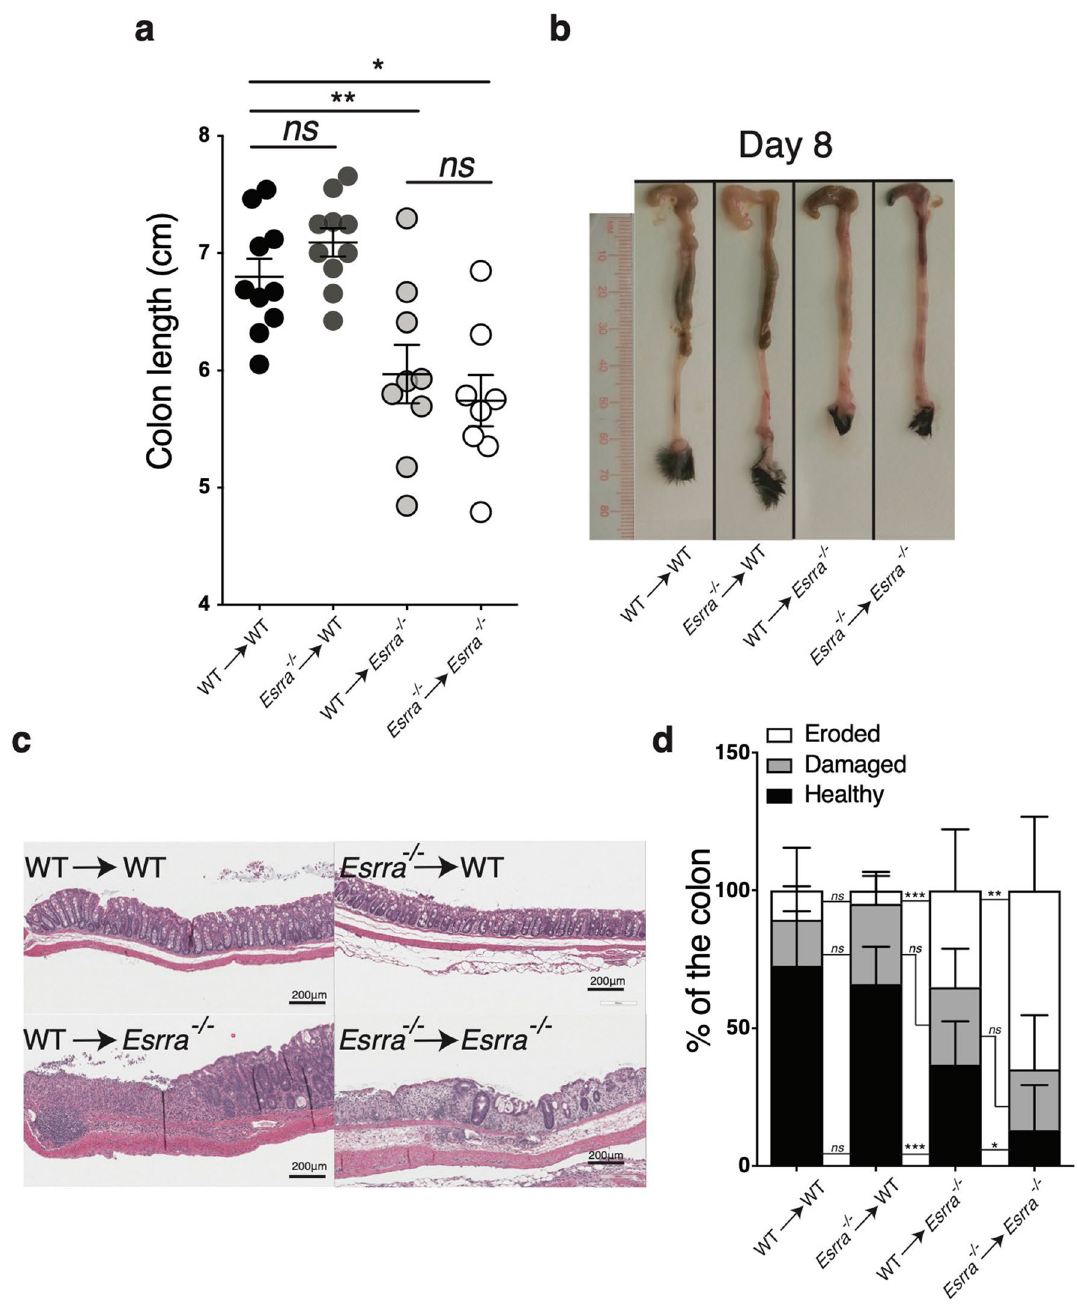
Figure 4. Expression of ERRα in the radio-resistant compartment mediates resistance to DSS colitis. ( a ) Colon length of bone marrow chimera mice on day 8 following DSS treatment. Data represent the mean ± SEM of n = 8–10 mice. Statistical analysis was performed with Student’s t -test, *p < 0.05, **p < 0.01. ns , not significant. ( b ) Representative photographs of colon and cecum on day 8 following DSS treatment. ( c ) Representative Hematoxylin and eosin (H&E) staining of colon sections derived from bone marrow chimera mice on day 8 following DSS treatment. ( d ) Intestinal tissue damage and erosion of bone marrow chimera mice on day 8 following DSS treatment, quantified by measuring the length of healthy, damaged, eroded sections, and expressed as a percentage of colon length. Data represent the mean ± SEM of 8–10 mice/genotype. Statistical analysis was performed using two-way analysis of variance (ANOVA, *p < 0.05, **p < 0.01, ***p < 0.001. ns , not